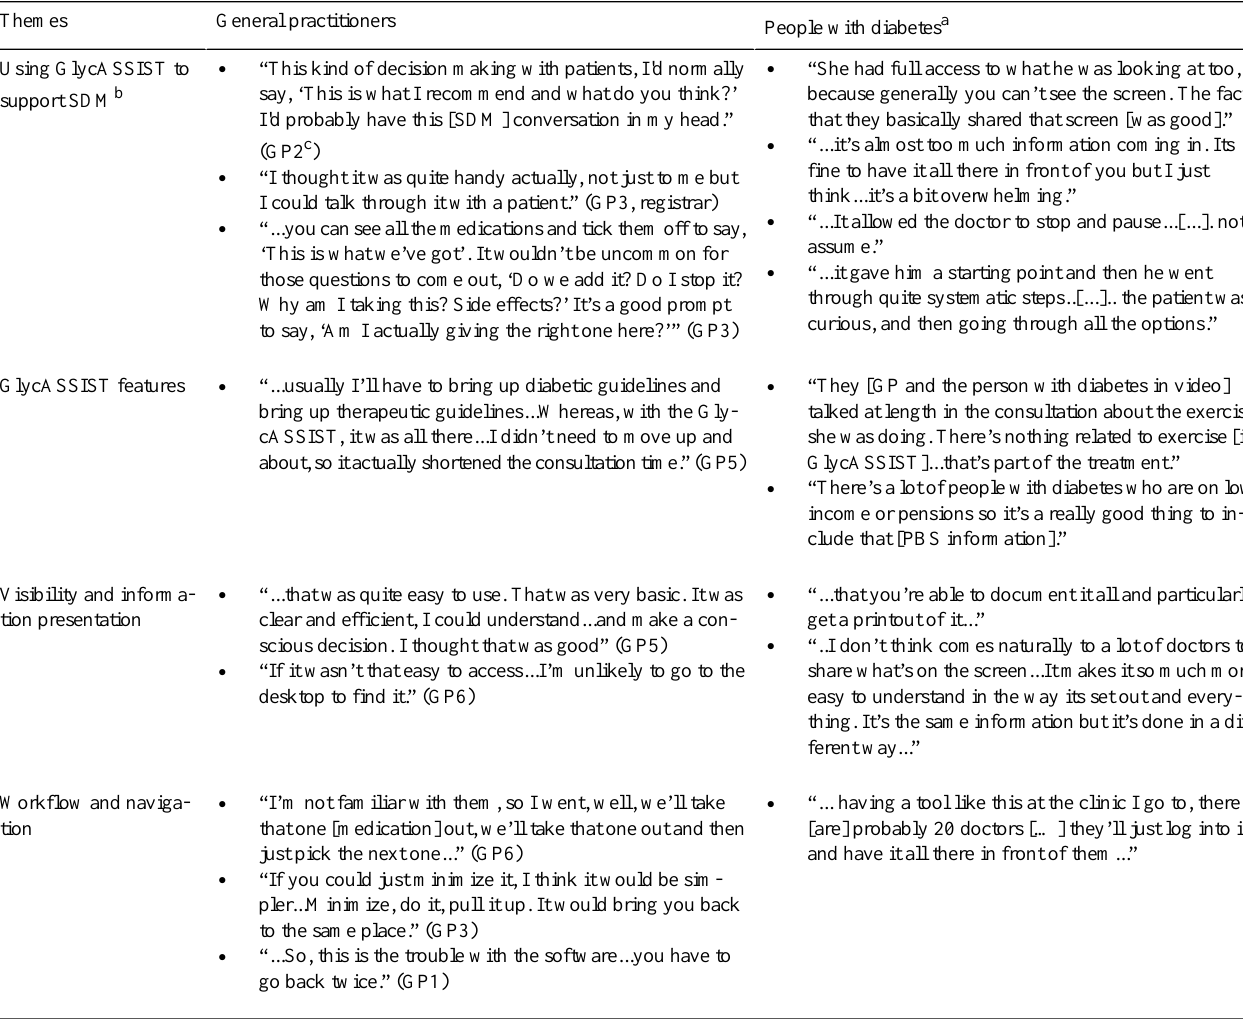
People with diabetes a General practitionersThemes